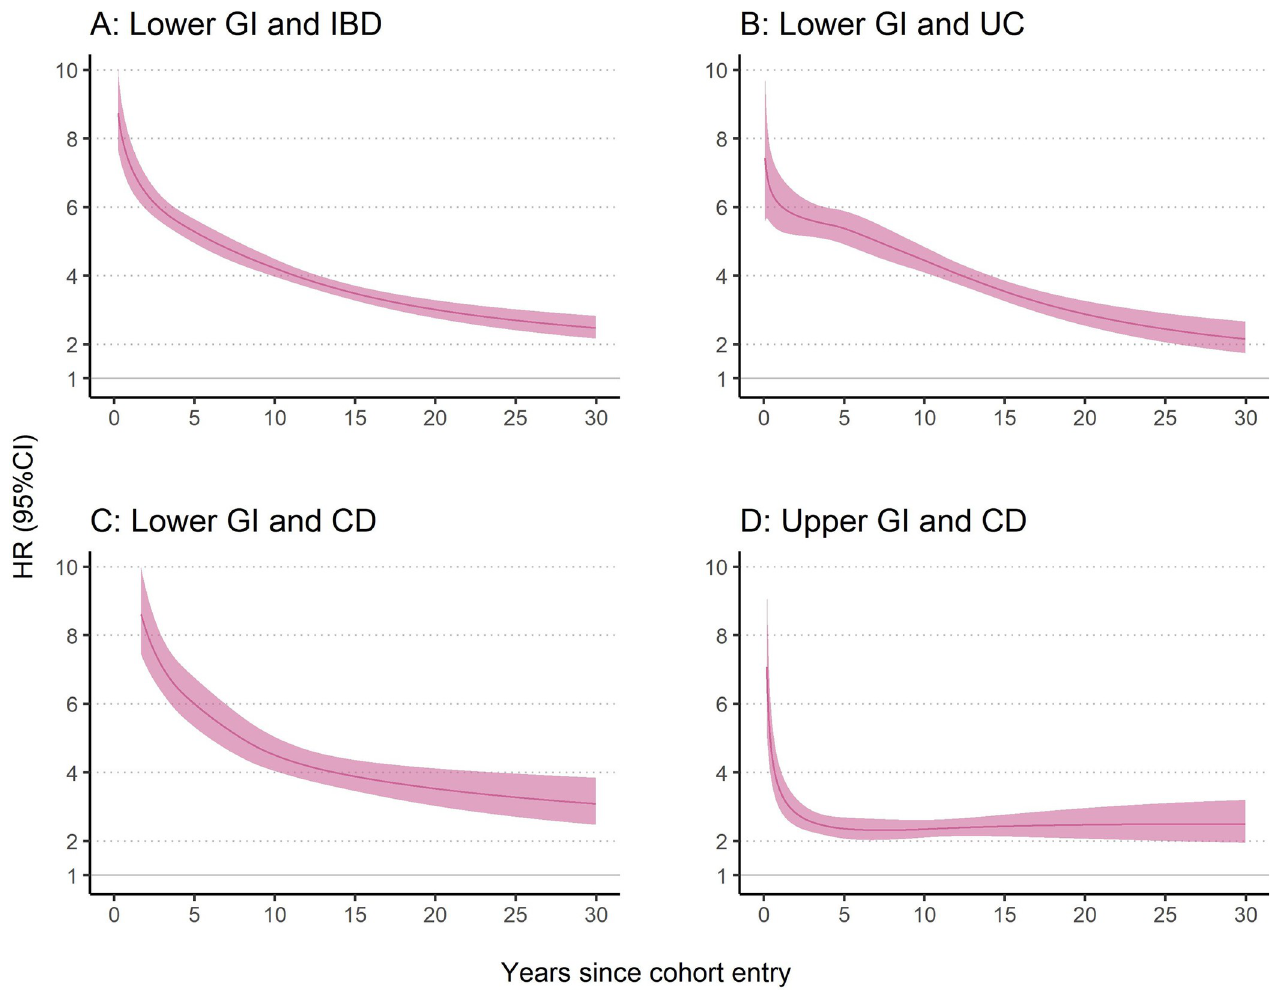
Fig 1. HR and 95% CI of IBD as a function of time since biopsy, comparing individuals with a GI biopsy result of normal mucosa with their matched population references. HR was estimated from the flexible parametric survival model conditioned on matching set (birth year, sex, county of residence, and calendar period) and further adjusted for country of birth, educational attainment, number of healthcare visits, Charlson comorbidity index, and history of GI diseases. Date of cohort entry was defined as 6 months after the index date. CD, Crohn’s disease; CI, confidence interval; GI, gastrointestinal; HR, hazard ratio; IBD, inflammatory bowel disease; UC, ulcerative